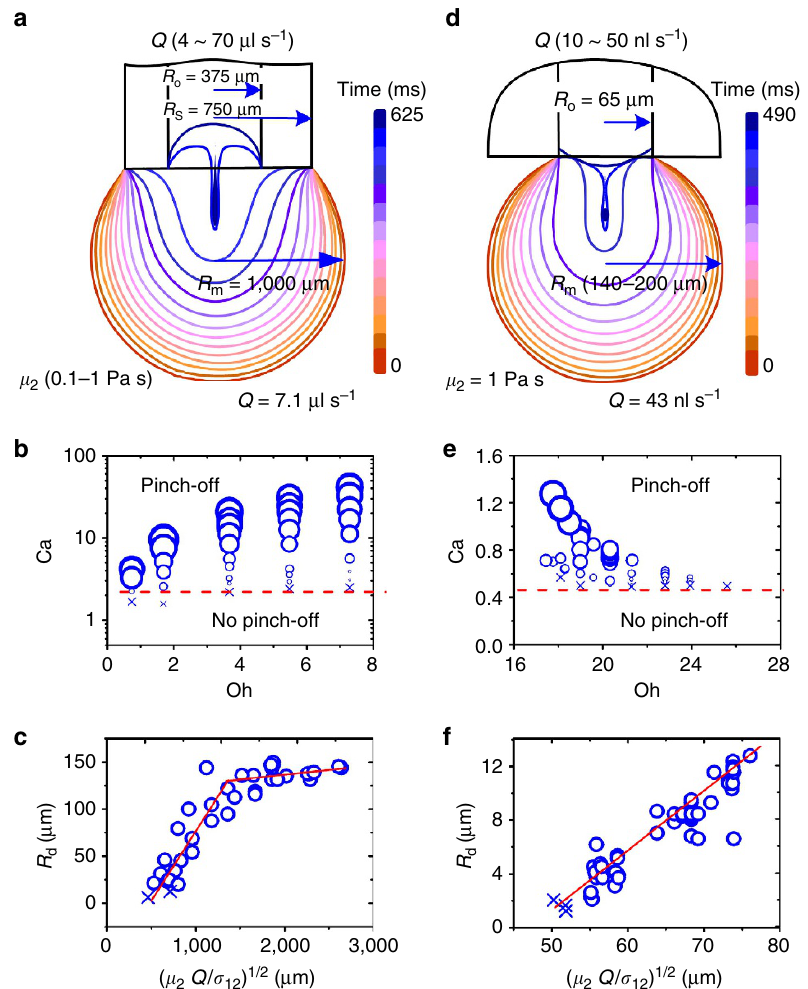
Figure 4 | Size of daughter droplets as a function of experimental parameters. ( a ) Geometry when the mother droplet is pinned at the outer radius of the capillary. The shapes were extracted from video images. ( b , c ) Experimental daughter drop sizes. ( d ) Geometry when the mother droplet is pinned at the inner radius of the capillary. ( e , f ) Experimental daughter drop sizes. The size of the symbol in b and e is proportional to the size of the daughter droplets, and the abscissa is given as dimensionless Ohnesorge number Oh ¼ m 2 [( r 1 þ r 2 ) s 12 R m ] (cid:2) ½ comparing viscous, inertial and interfacial forces. ( c , f ) The linear relationship between R d and ( m 2 Q/ s 12 ) 1/2 . Crosses indicated dispensing under formation of several droplets of similar sizes (transition regime) where R d is the average radius of the several droplets formed due to the break-up of the thin liquid